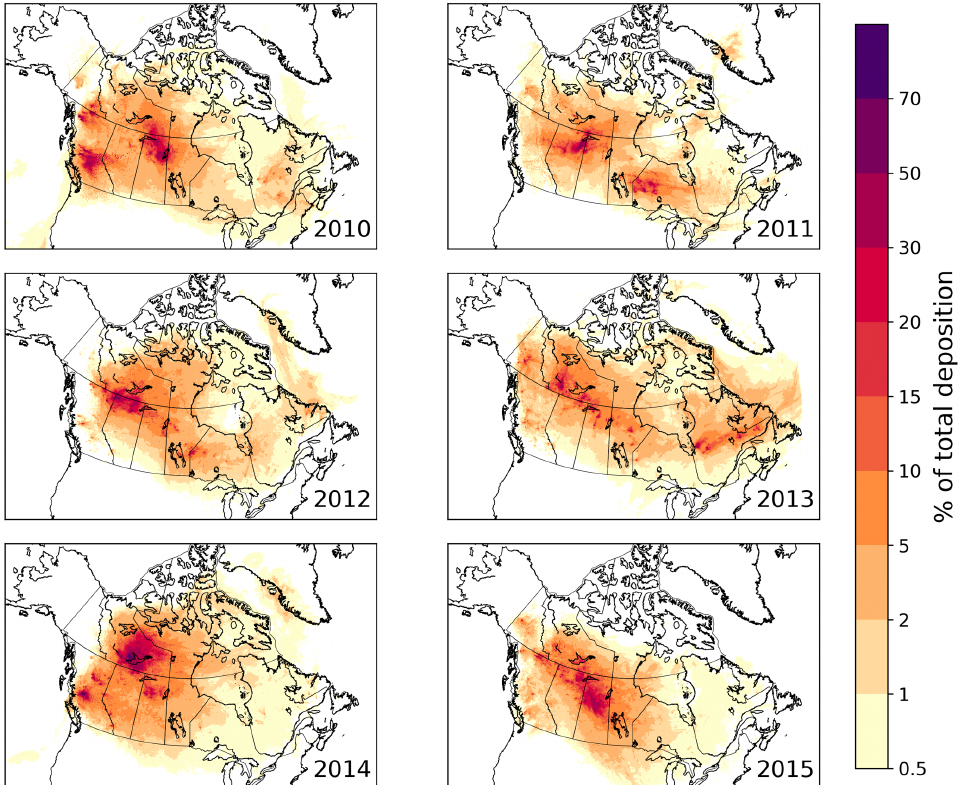
Figure 15. Percentage contribution of deposition from Canadian biomass burning emissions (prior with PBM biomass burning emissions scenario) to the total deposition from all sources during the burning season (May–September) for 2010–2015.